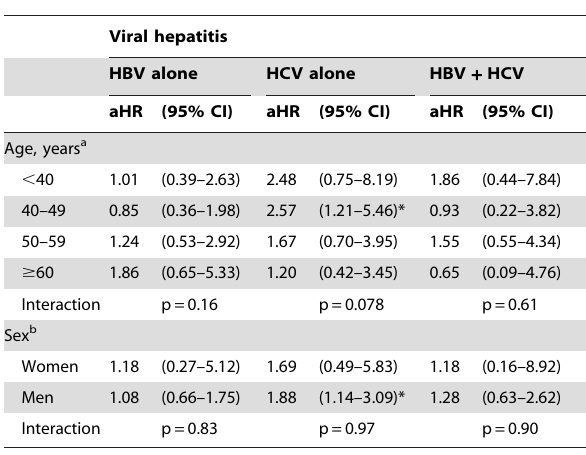
Table 3. Adjusted HRs and 95% CIs of oral cavity cancer associated with viral hepatitis compared with non-viral hepatitis by age and sex